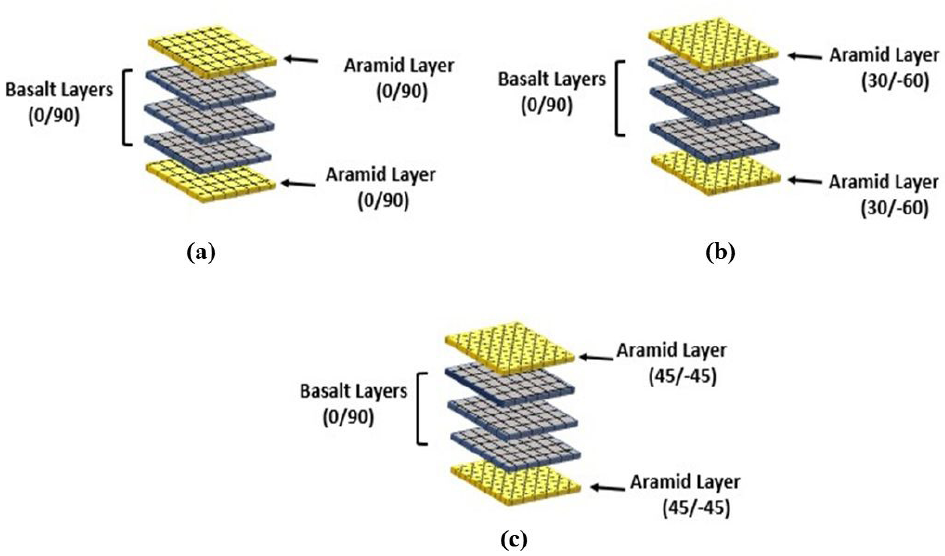
Figure 1. Schematic representation of (a) (0 1A /0 3B /0 1A ) (b) (30 1A /0 3B /30 1A ) and (c)(45 1A /0 3B /45 1A ) interply hybrid composites.